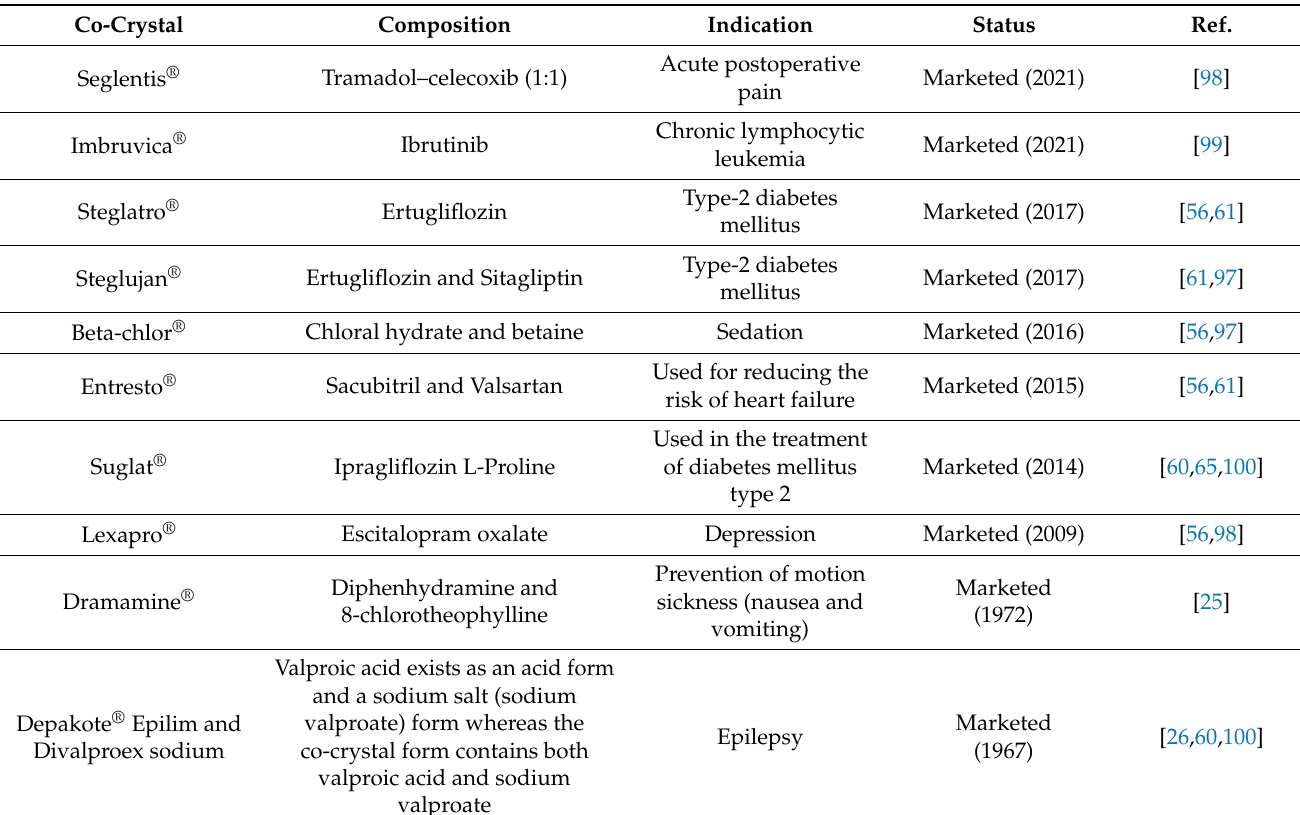
Table 4. Summary of co-crystal formulations presently